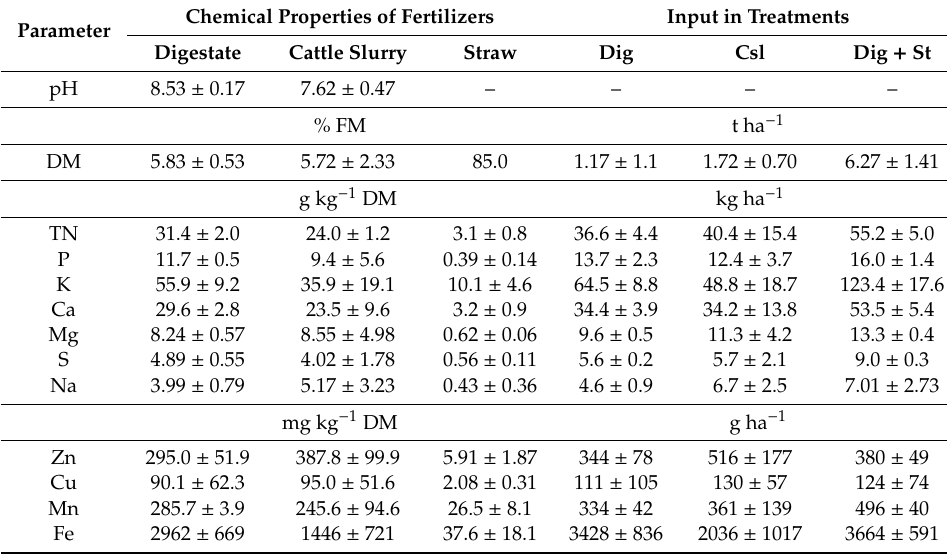
Table 3. Chemical properties of digestate, cattle slurry, and straw and annual input of dry matter and nutrients into soil with fertilizers (mean value ± standard deviation, n =